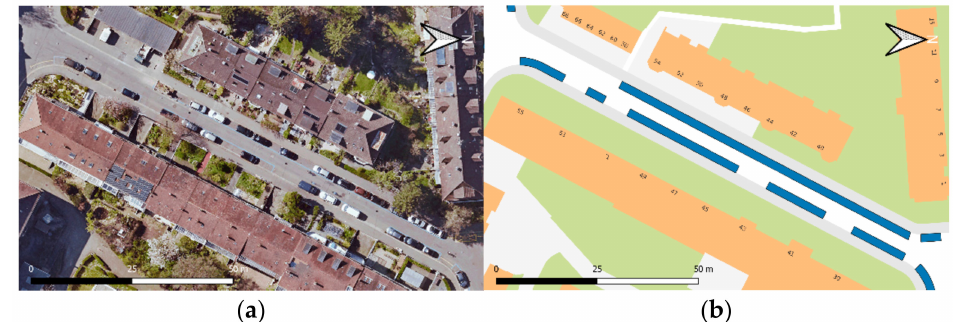
Figure 5. Test site to evaluate the approaches provided in OpenPCDet on our own data. The test road leads through a residential neighborhood in the city of Basel with parking spaces on the left and right side. ( a ) Aerial image of the test road; ( b ) map with the parking spaces (blue) (data source: Geodaten Kanton